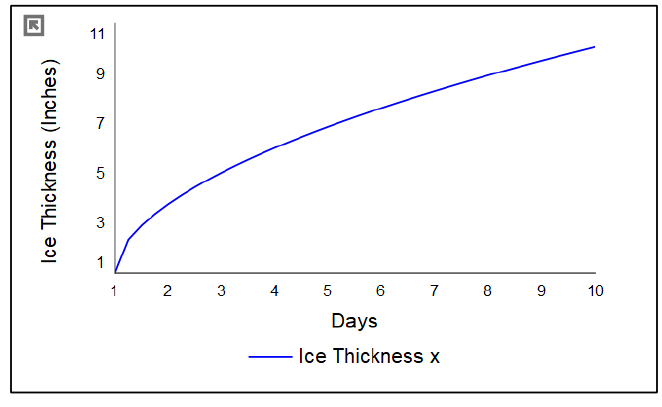
Fig. 15. Ice thickness vs